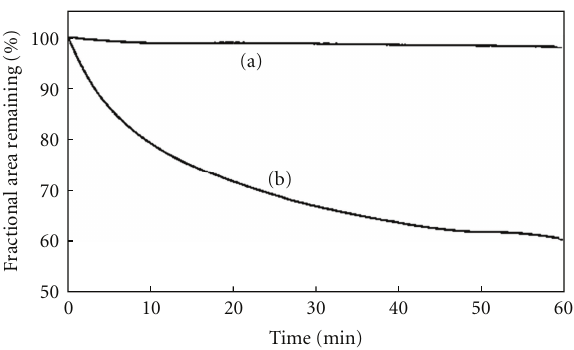
Figure 24: Area decay curve of the L films of the salt (a) and the amide (b) at a surface pressure of 25 mNm − 1 .